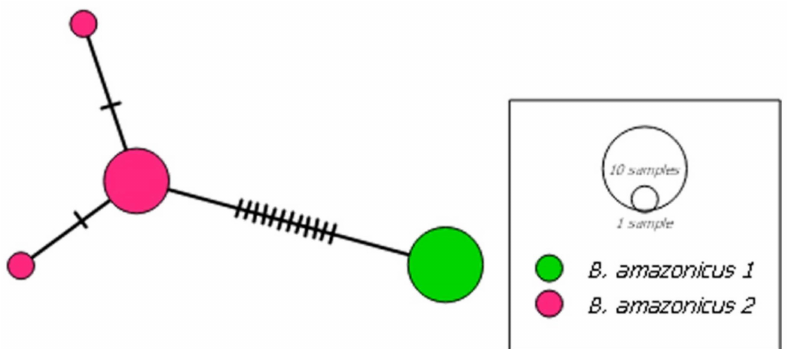
Figure6. Haplotypenetworkofthetwomitochondriallineages(MOTUs)identifiedin Bryconamazonicus . Each circle represents a single haplotype and its size is proportional to its frequency. Table 3. Analysis of Molecular Variance (AMOVA) of the samples of Brycon amazonicus. Source of the Variation d.f. Sum of Squares Components of the Variance % Variation 1